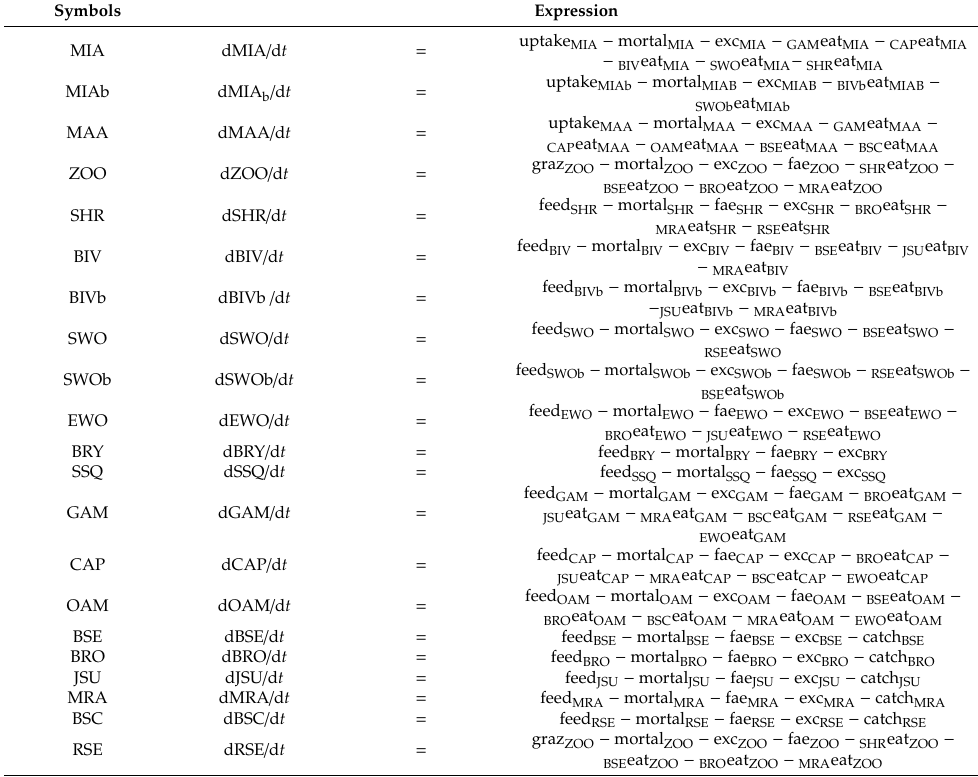
Table 1. Mass balance equations for the compartments used in the present numerical model.